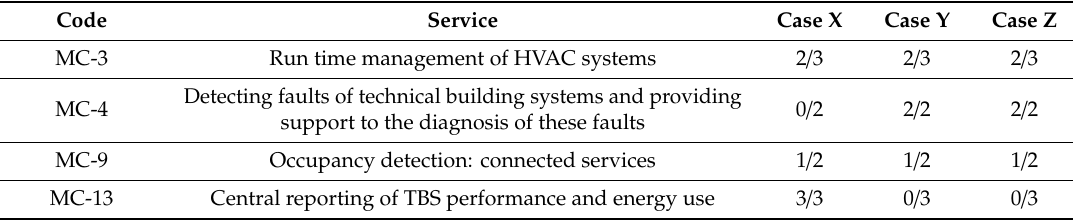
Table 12. The functionality levels in the main domain of monitoring and control